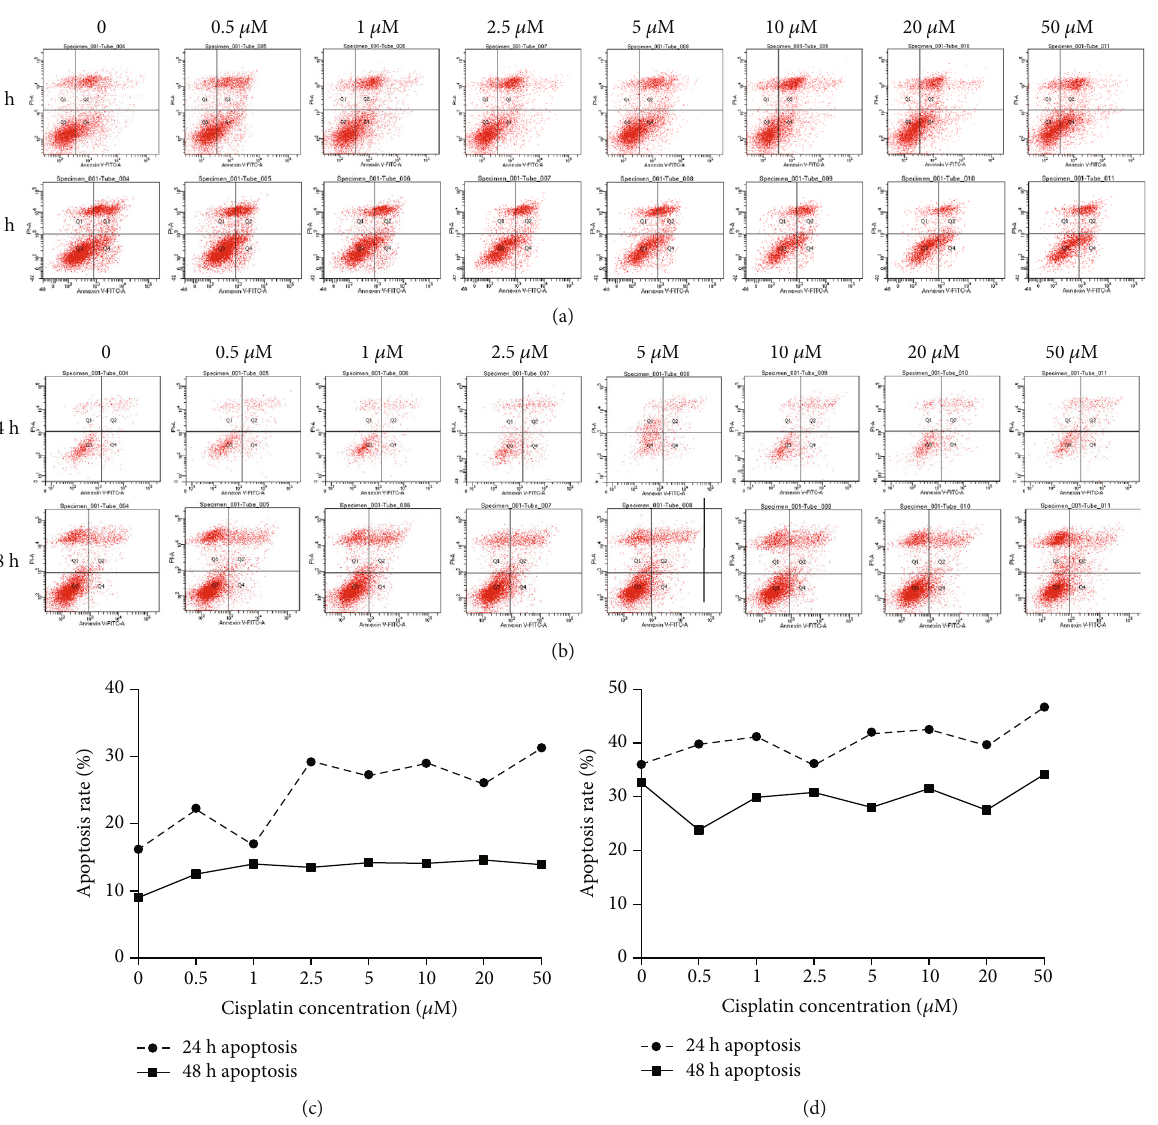
Figure 2: E ff ects of cisplatin on apoptosis of bladder cancer cells under normoxic and hypoxic conditions. (a, c) Under normoxia, the apoptosis rate was signi fi cantly increased with increase of drug concentration, from 16.2% to 31.3% at 24h and 9% to 14.6% at 48 h. (b, d) Under hypoxia, the apoptosis rate was slightly increased with increase of drug concentration, from 36% to 46.7% at 24h and 32.6% to 34.2% at